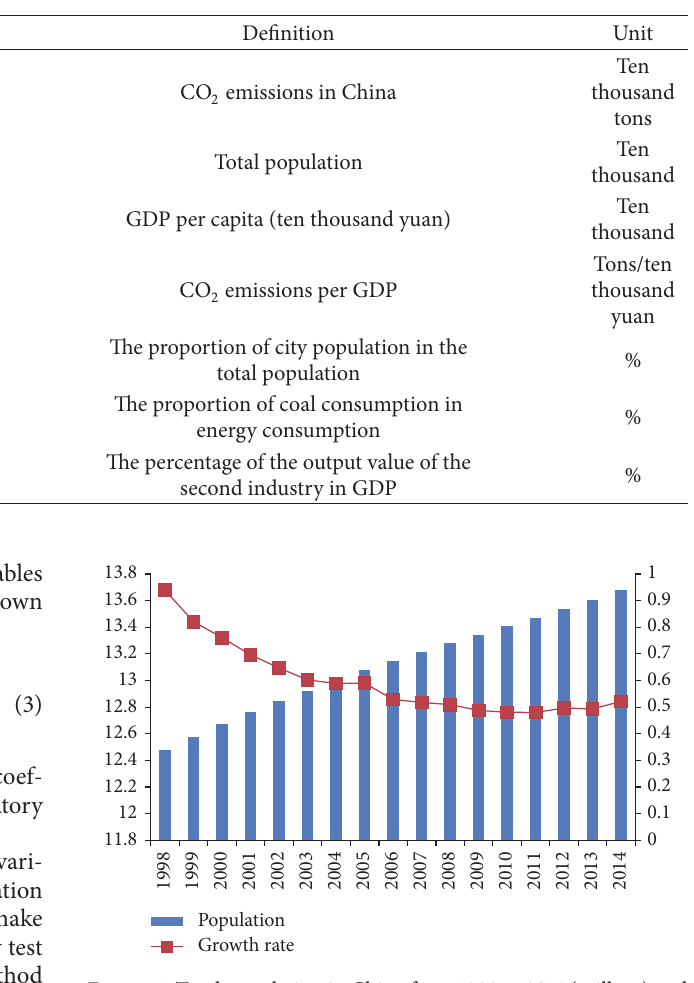
Figure 1: Total population in China from 1998 to 2014 (million) and the growth rate